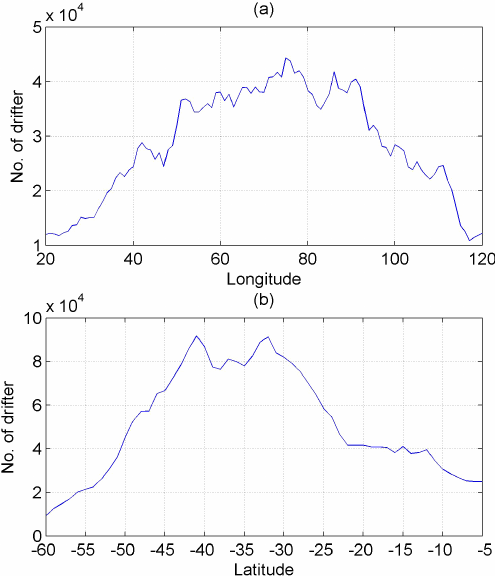
Figure 4. (a) Meridional and (b) zonal accumulated number of drifters as a function of longitude and latitude,